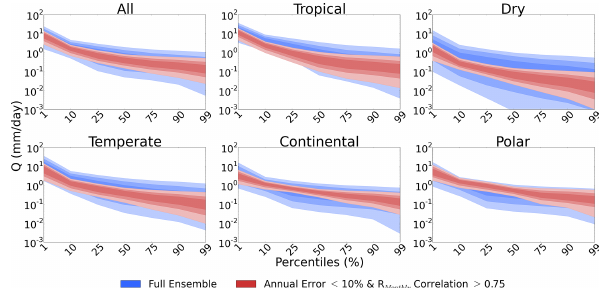
Figure 6. Climate-averaged ensemble spread in the daily flow du- ration curve. The spread in flow duration curve is calculated for all 10000 ensemble members. The blue shading shows the spread of the entire ensemble while the red shading shows the spread for pa- rameter sets that have an annual mean runoff within 10% of the observed runoff and normalized monthly runoff correlation above or equal to